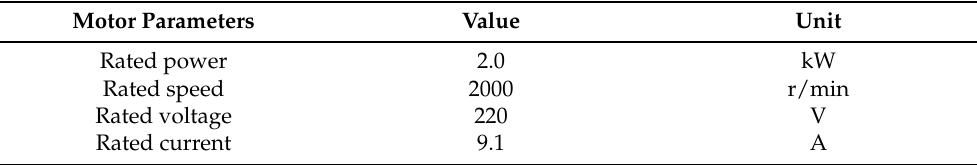
Table 2. Parameters of